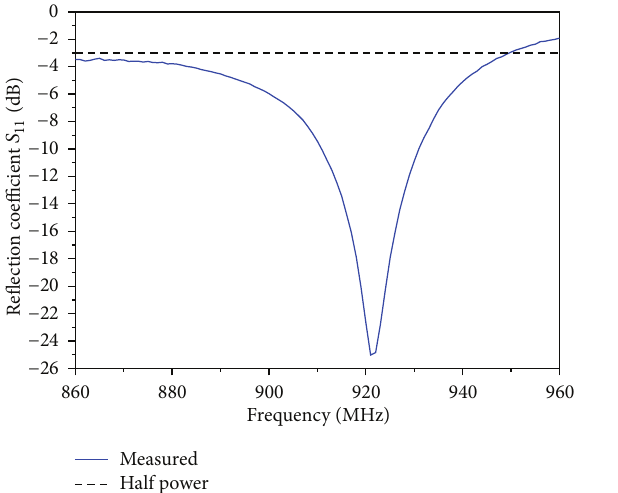
Figure 14: Measured reflection coefficient of the proposed